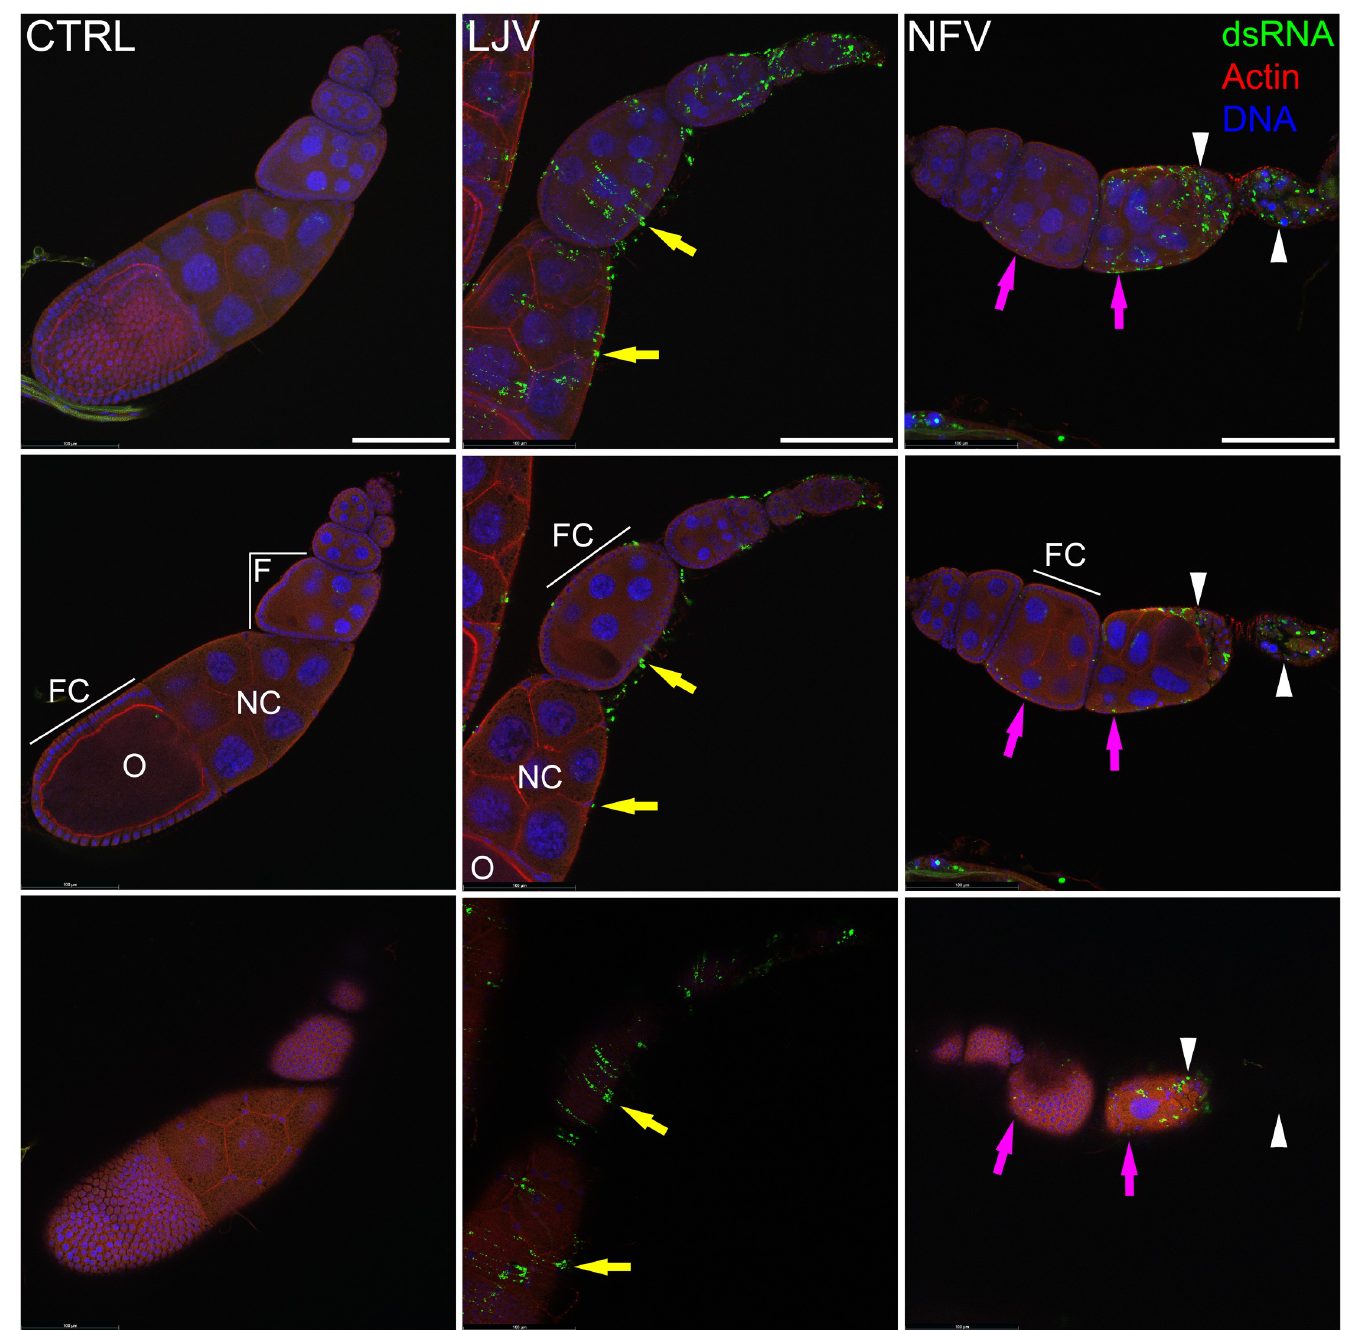
Fig 4. Immunostaining of ovaries showing the location of viral dsRNA. D . melanogaster ovaries were stained 10 dpi with DAPI to visualise DNA (blue), phalloidin to visualise the actin cytoskeleton (red), and mouse monoclonal antibody J2 to detect viral dsRNA (green), and imaged with a confocal microscope. From left to right, columns show individual ovarioles of females uninfected (CTRL), and infected with LJV and NFV. Top panels are a maximum intensity projection of 6 confocal planes taken from the same ovariole. Middle and bottom panels are individual confocal planes showing a transverse section of the ovariole (middle) or a superficial section (bottom). Note the dsRNA signal is absent from the CTRL, present at the ovariole surface (LJV, yellow arrows) or within the follicular epithelium (NFV, pink arrows). Letters represent oocyte (O), nurse cell (NC), follicle (F) and follicle cells (FC). In the case of NFV infection, infected follicles fail to progress through oogenesis and degenerate completely (white arrowheads). Scale bar indicates 100 μ